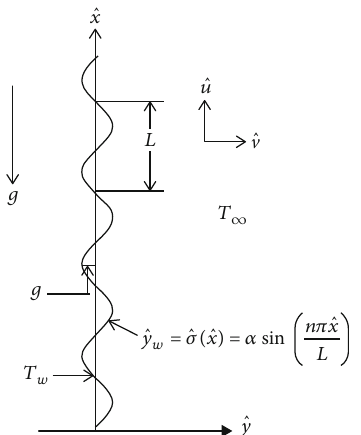
Figure 1: The physical model and the coordinate system of the